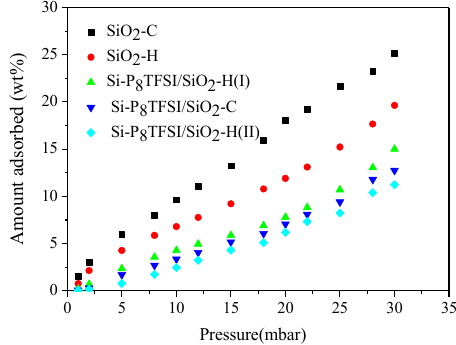
◦ C on silica and modified